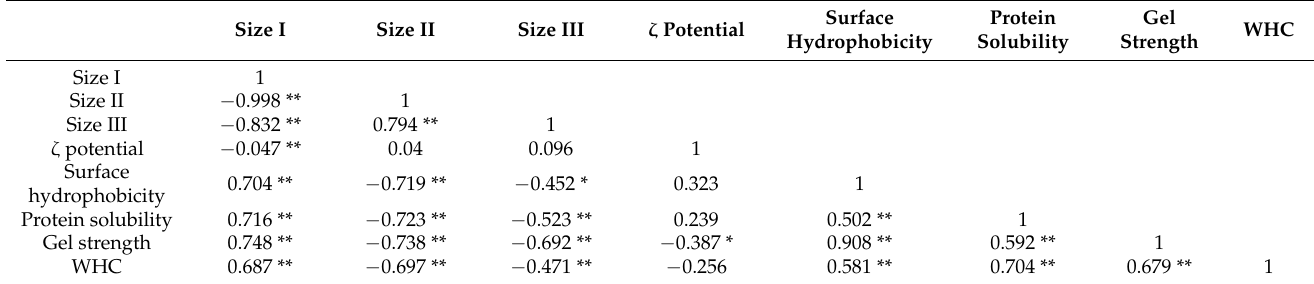
Table 1. Correlation analysis. * and ** indicate significant levels at p < 0.05 and p < 0.01, respectively. Size I represents a protein with a volume fraction less than 106 nm, Size II represents a protein with a volume fraction of 106 to 1110 nm, and Size III represents a protein with a volume fraction greater than 1110 nm (the specific data is given in Table A1).